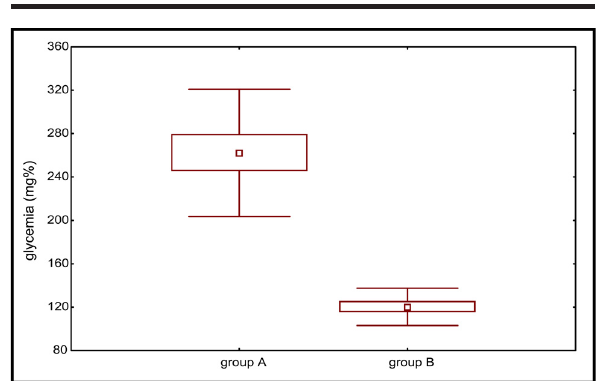
FIGURE 1 - Graphic presentation of the determination of glycemia (mg%) in the animals of group A (90 minutes of ischemia and 15 minutes of reperfusion) and group B (sham operation).